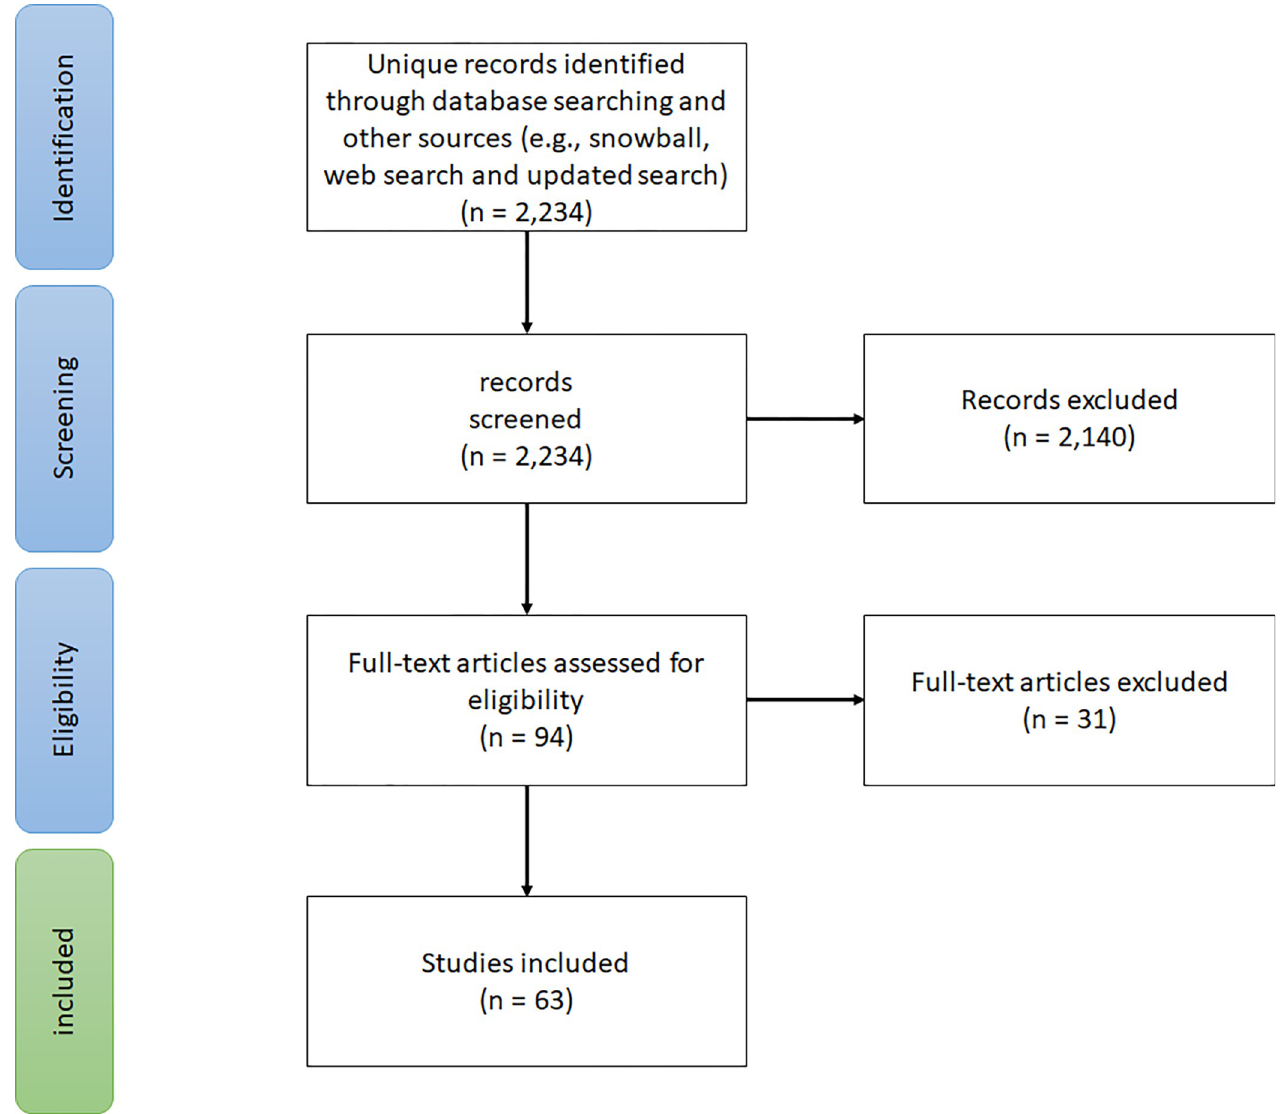
Fig 1. Flowchart of the study selection process (adapted from Peters, Micah DJ et al, (2015) [17].